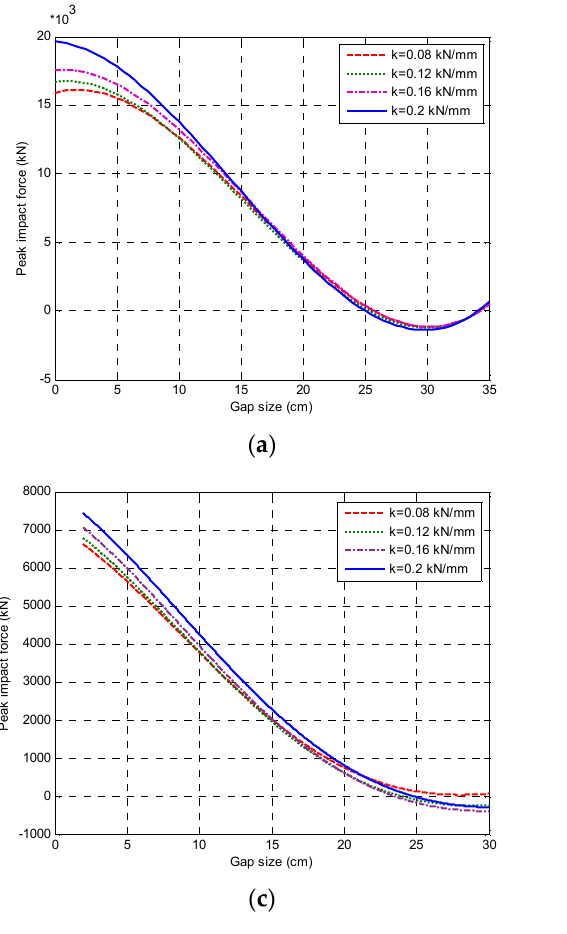
Figure 14. Peak values of impact force for different rubber bumper stiffnesses and gap sizes under different seismic excitations: ( a ) Parkfield; ( b ) Kobe; ( c ) San Fernando; ( d ) Tabas.